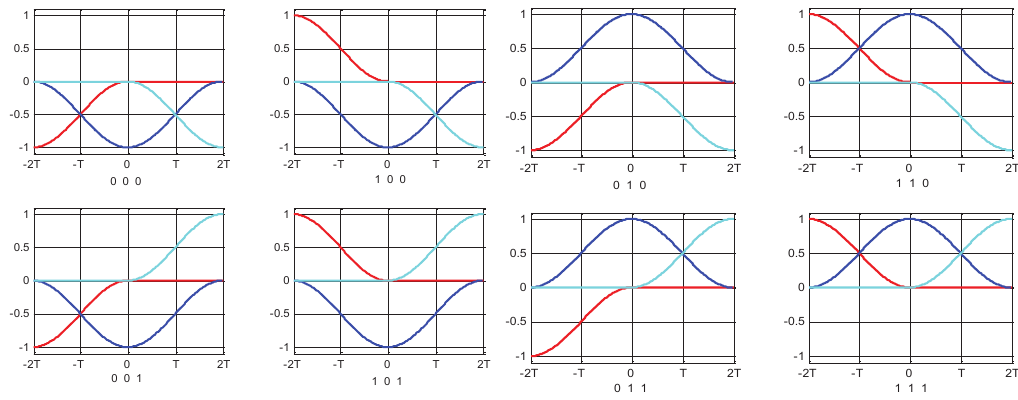
Figure 2. Composed modes of three random baseband symbols in the interval [ − 2 T ,2 T ] .